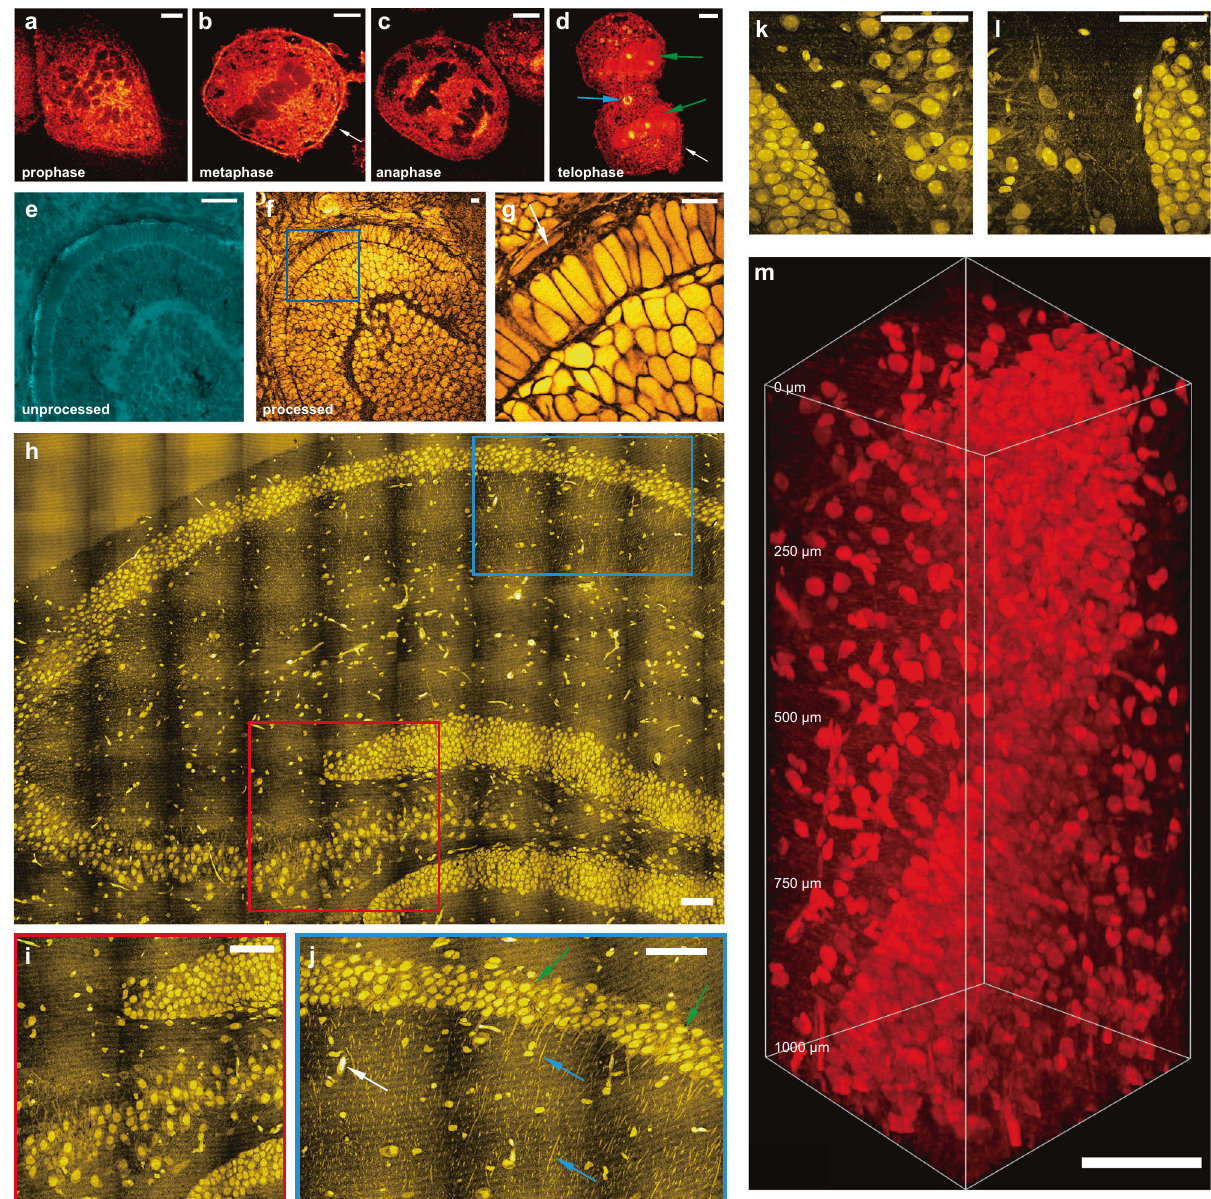
Fig. 2 Super-resolution three-dimensional VISTA imaging of cells and tissues. a – d Mitotic HeLa cells in prophase ( a ), metaphase ( b ), anaphase ( c ), and telophase ( d ). e – g Zebra fi sh embryonic retina before processing and after expansion: unprocessed ( e ), expanded ( f ), and the zoom-in view from the boxed region in ( f , g ). h A mosaic VISTA image of hippocampal tissue. i – l zoomed-in high-resolution view from color-boxed areas ( i red box; j blue box) and selected regions in ( h ). Representative neuronal cell bodies, neuronal processes, and likely blood vessel cross-sections are indicated by green, blue, and white arrows, respectively in ( j ). m 3D volume VISTA imaging of a hippocampal tissue throughout 1000 μ m depth. Scale bars: 20 μ m ( a – g ) and 200 μ m ( h – m ). For processed samples, the length scale is in terms of distance after